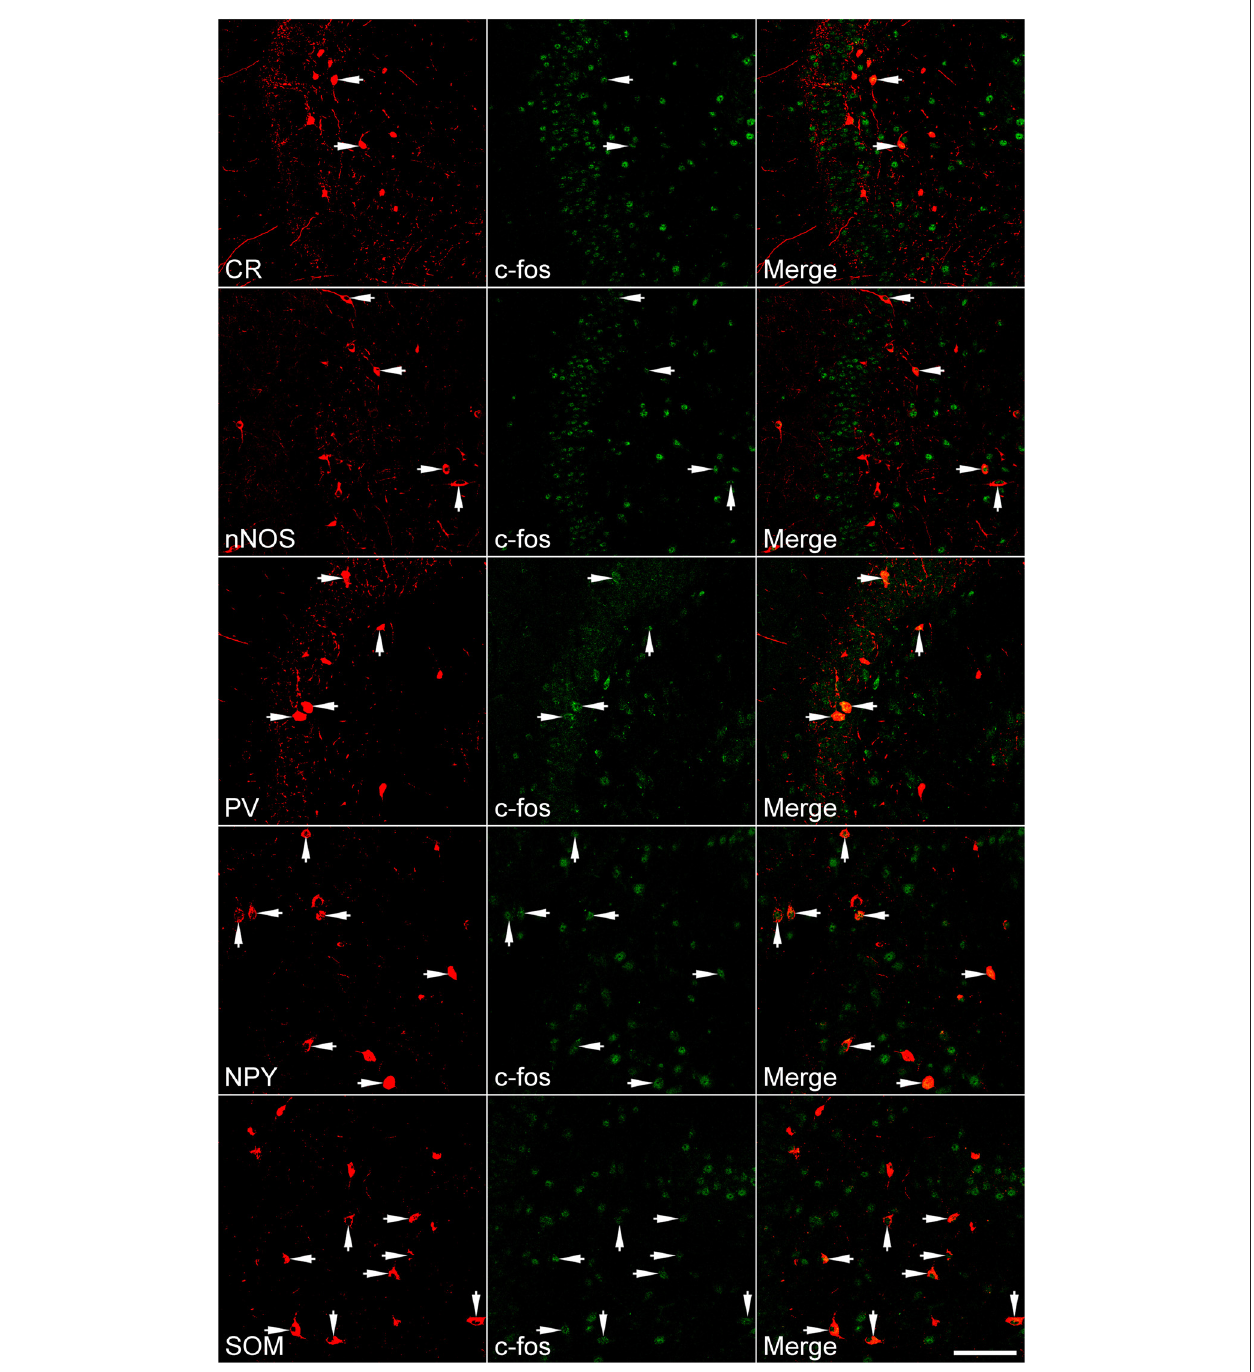
FIGURE 4 | Representative images show c-fos expression in neurochemically defined interneuron subtypes in the dentate gyrus more than 10 weeks after SE . SE was induced by an intraperitoneal injection of pilocarpine. Left column: neurochemically defined interneuron subtypes (CR, calretinin; nNOS, neuronal nitric oxide synthase; NPY, neuropeptide Y; PV, parvalbumin; SOM, somatostatin); Middle column: c-fos immunoreactivity; Right column: overlay of marker and c-fos immunoreactivities. Arrows indicate marker-positive cells with c-fos expression. Scale bar = 100 µ m (applicable to all panels).